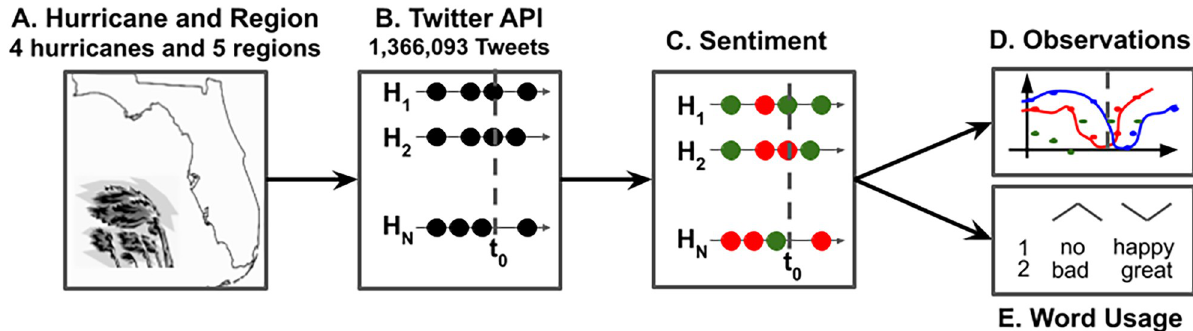
Fig 1. An outline of our methodology. A) We retrieve bounding box coordinates of the US Landfall of 4 major hurricanes in 5 regions. B) We then download the geo-located tweets from the affected region during the hurricane using the Twitter API. C) Using sentiment analysis tools, we quantify the valence of the tweets for. D) We bootstrap the sentiment and then build exponential fits. E) Finally, we look at the change in frequency of VADER lexicon terms before , during , and after the hurricane landfall.